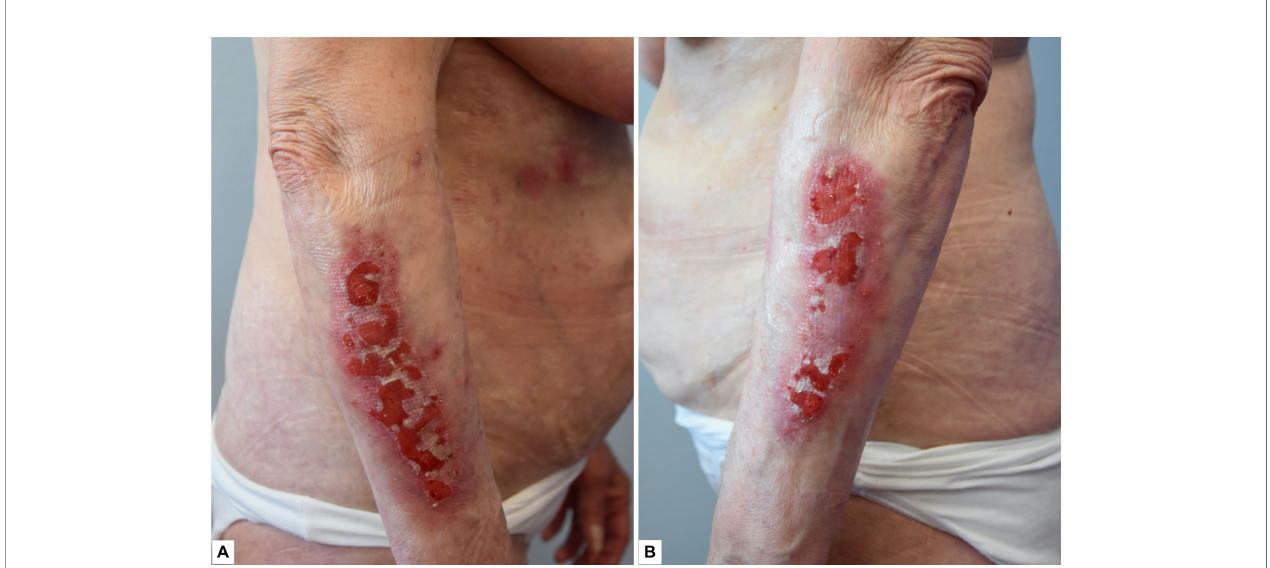
FIGURE 2 | (A, B) Erosions superimposed on whitish plaques with atrophic epidermis at the right and left upper